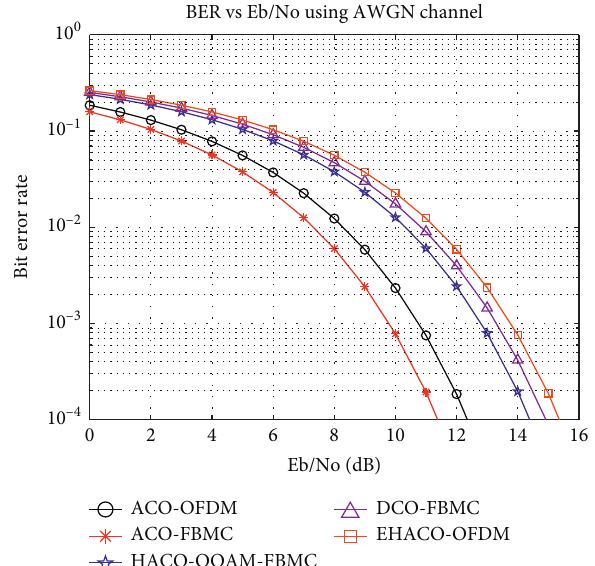
Figure 7: Simulation of BER of ACO-FBMC, DCO-FBMC, EHACO-OFDM, and HACO-OQAM-FBMC.